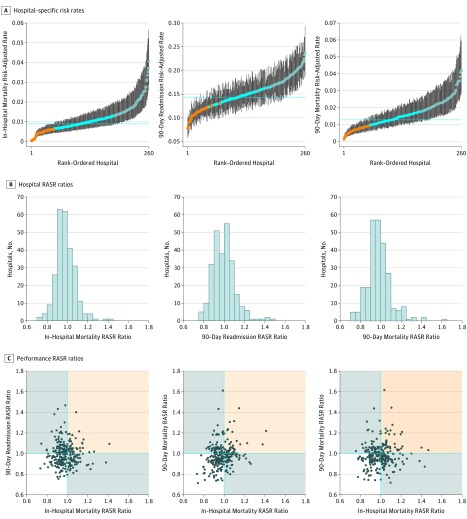
Distributions of Performance Metrics Among 260 Hospitals With at Least 10 Cancer Surgery Patients per Year, on Average, for In-Hospital Mortality, 90-Day Postdischarge Readmission and 90-Day Postdischarge MortalityA, Model-based hospital-specific risk rates and 95% CIs; orange and blue dots indicate that the 95% CI is entirely below and above, respectively, the statewide rate (dotted lines). B, Number of hospitals in discrete categories of model-based risk-adjusted standardized rate (RASR) ratios. C, Bivariate scatterplots for all three 2-way combinations with each point representing a hospital; hospitals in the nonshaded area had optimal performance with RASR ratios less than 1.0, indicating lower-than-expected rates, for both outcomes; hospitals in the orange-shaded region had RASR ratios greater than 1.0, indicating higher-than-expected rates, for both outcomes; hospitals in the gray-shaded region had lower-than-expected rates for 1 metric and higher-than-expected rates for the other.